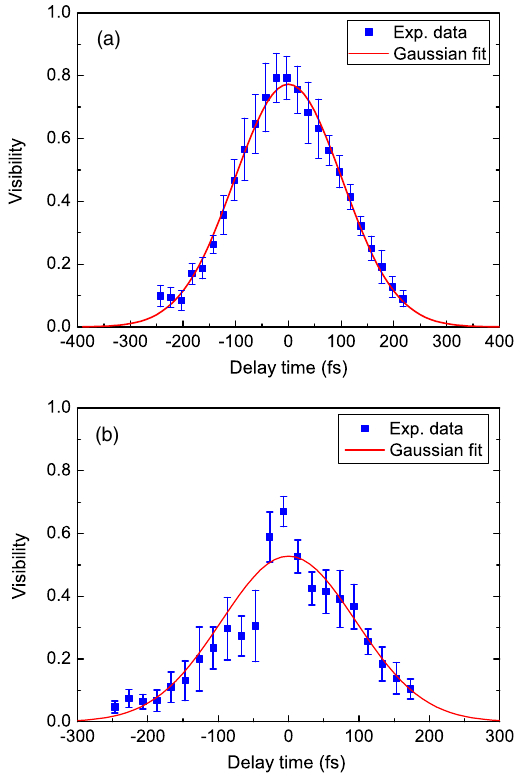
FIG. 3. Temporal coherence measurement for (a) the second harmonic and (b) the third harmonic of the 1200 nm seed laser. The solid curves are the Gaussian fits, which give the coherence time (HWHM) of (a) 120 (cid:3) 2 fs and (b) 113 (cid:3) 6 fs .